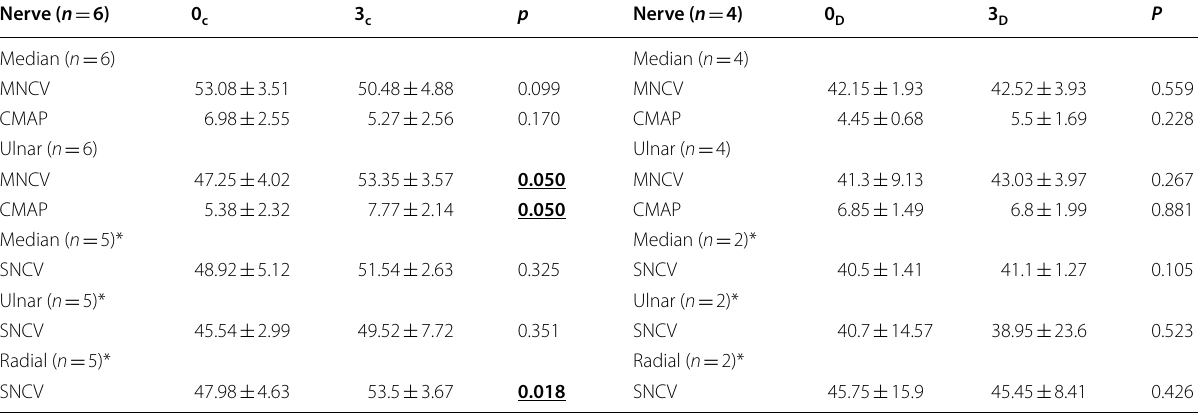
Table 2 Effect of ESA therapy on some of neurophysiological findings in non-diabetic patients in comparison to those of diabetic